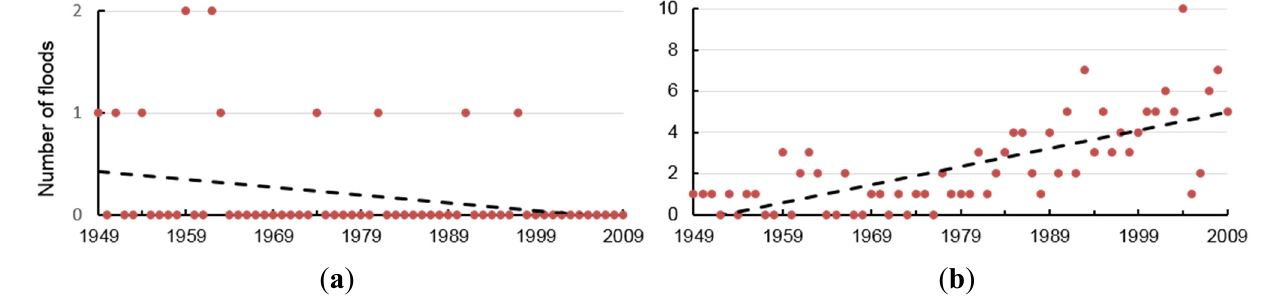
Figure 5. Trends of overbank flood ( a ) and waterlogging ( b ) in Shanghai.